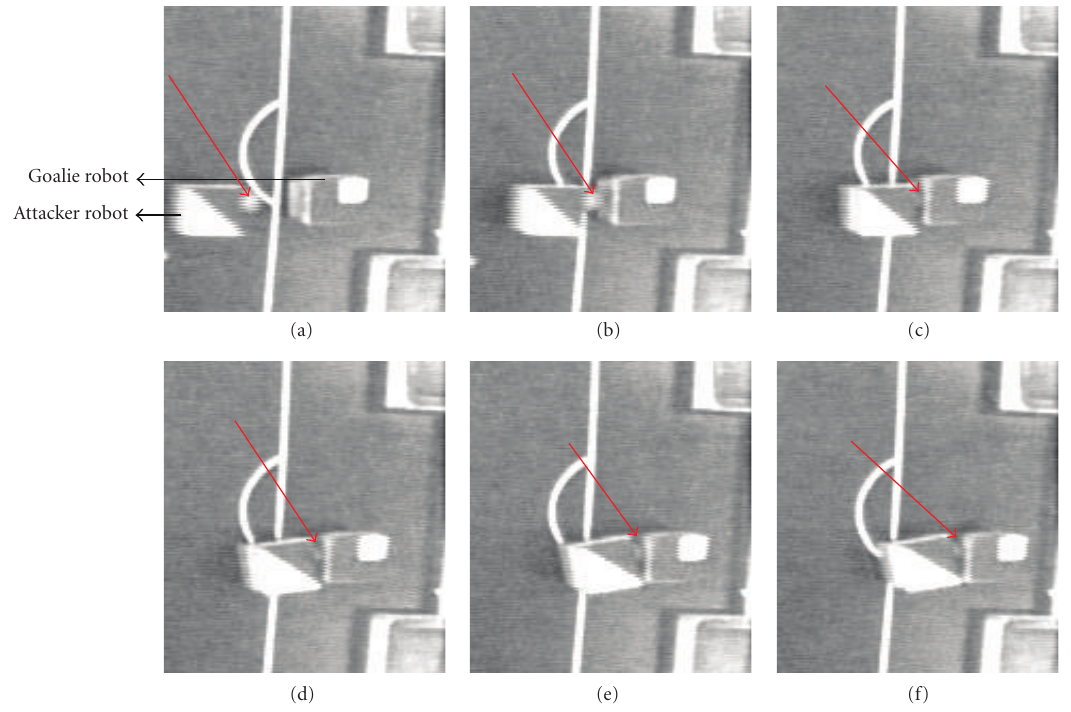
Figure 13: Six real time frames to decide charging foul behavior. (a-b) The attacker is moving close toward the goalkeeper with the ball. (c) Two robots are about to collide with the ball in between them. (d-e) The attacker is pushing the goalkeeper backward with the ball in between them. (f) The goalkeeper is pushed into the goal area (Note that the arrow head in between robots is the ball position). Table 8: The % FLPE crisp values of six frames for Figure 15.